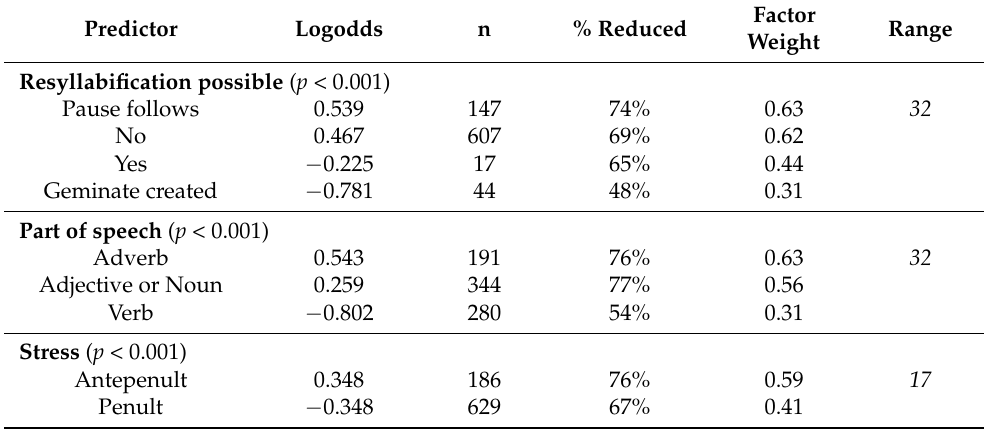
Table 6. MEM for all speakers together, comparing Reduction to Deletion (N = 815).